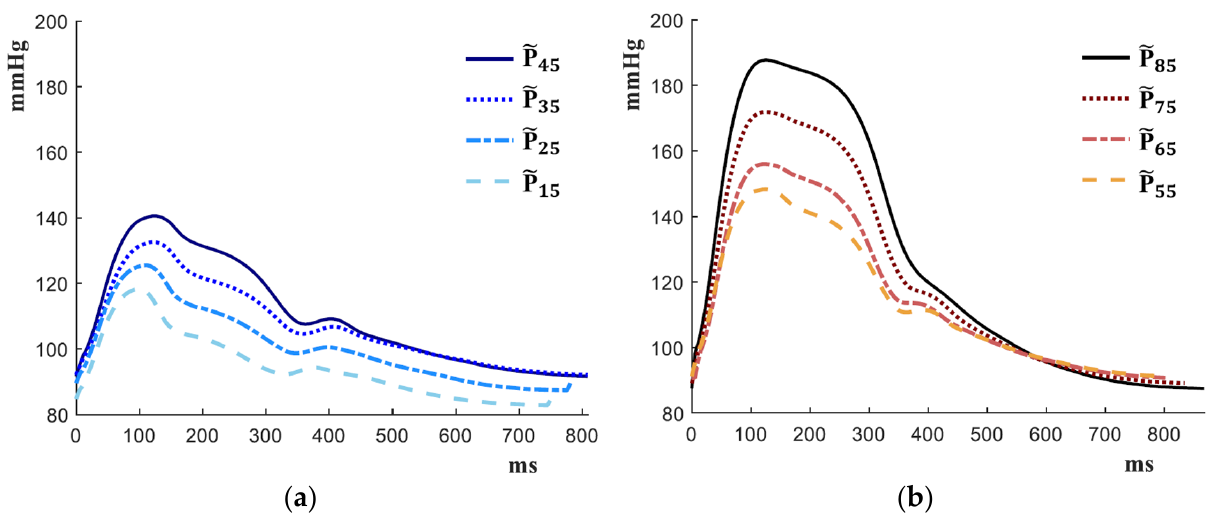
Figure 5. Approximated blood pressure waveforms by age: ( a ) Pulse pressure waveforms from 15 to 45 years old. ( b ) Pulse pressure waveforms from 55 to 85 years old.